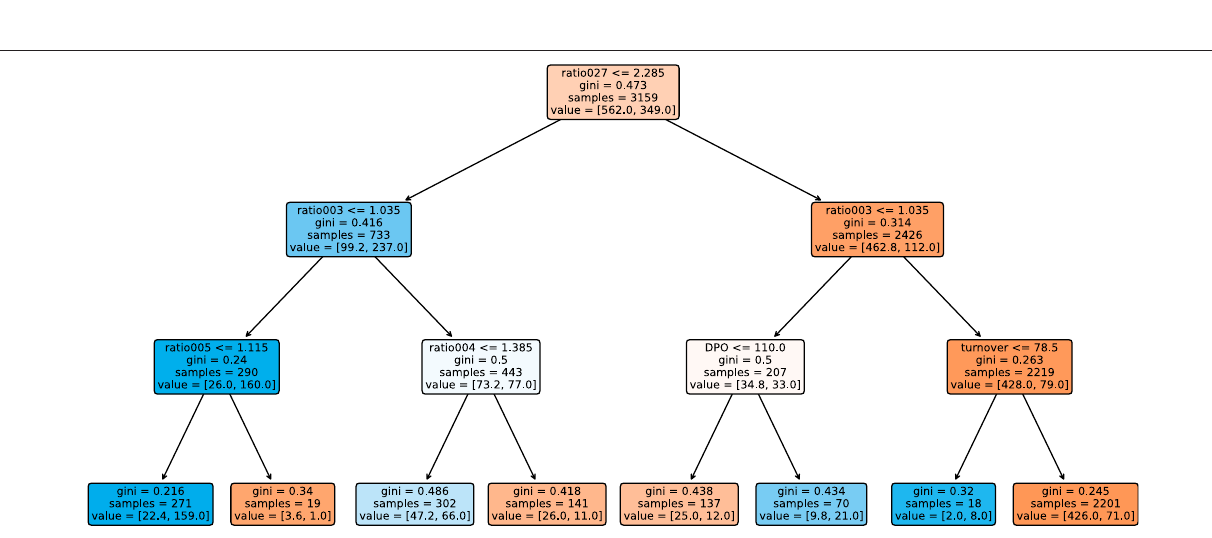
Frontiers in Arti fi cial Intelligence |